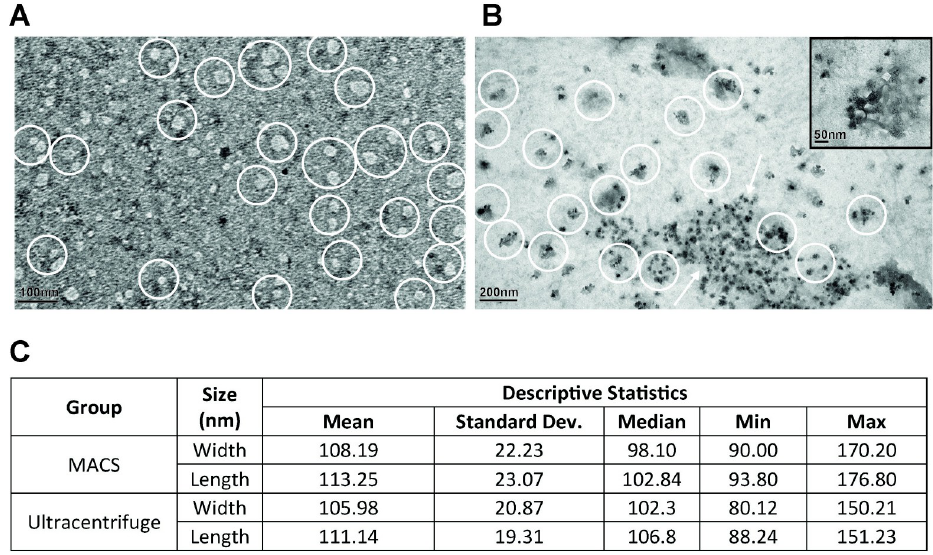
Fig 3. Transmission electron micrographs of exosomes. Negatively stained spherical structures in a range of sizes between 80–150 nm and 90–170 nm at the (A) ultracentrifugation (scale bar:100nm) and (B) MACS (scale bar:200nm, inset 50nm) groups, respectively. Exosomes are marked with white circles and exosome clusters are pointed by arrows. Descriptive Statistics (C) of exosome sizes are shown.